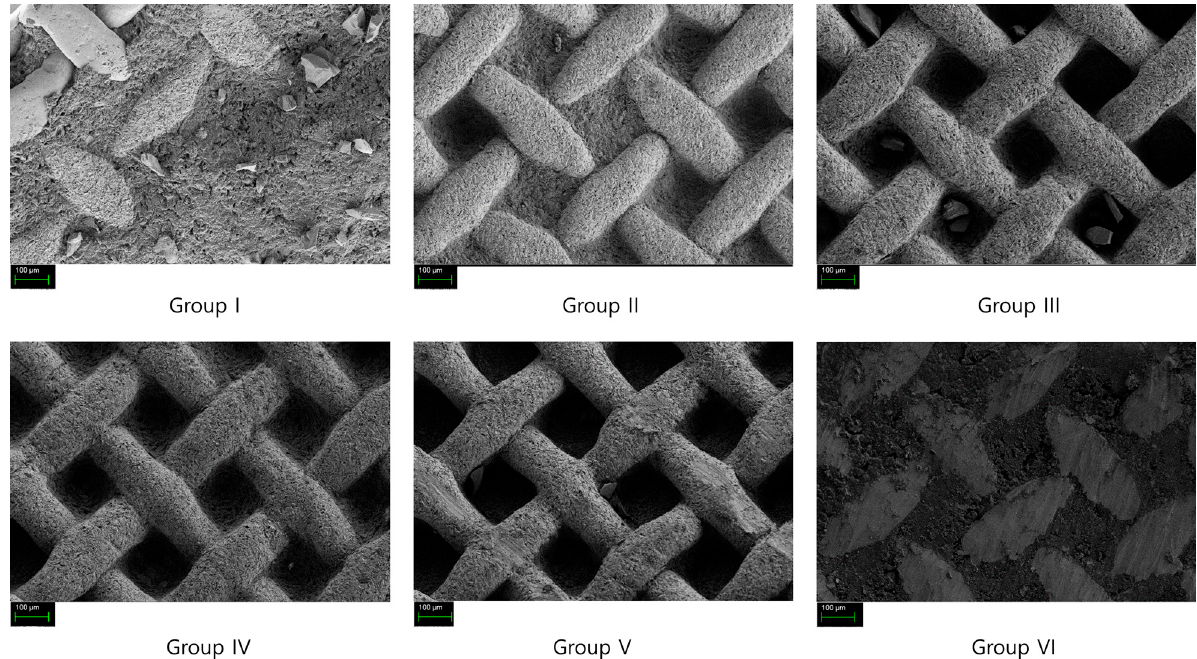
Figure 6. Scanning electron micrographs of bracket bases. See Table I for group description. Magnification